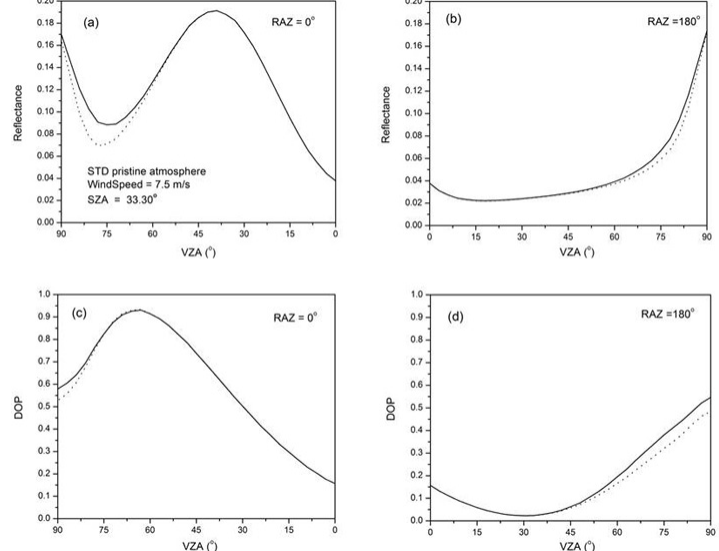
Fig. 12. The total reflectance and DOP of the ocean–atmosphere system on the principal plane, which is calculated with the ADRTM at the wavelength of 670nm from the pristine US standard (STD) atmosphere over the ocean without wave shadow (solid curve) and with wave shadow (dashed curve). The wind speed is 7.5ms − 1 . The SZA is 33.30 ◦ .